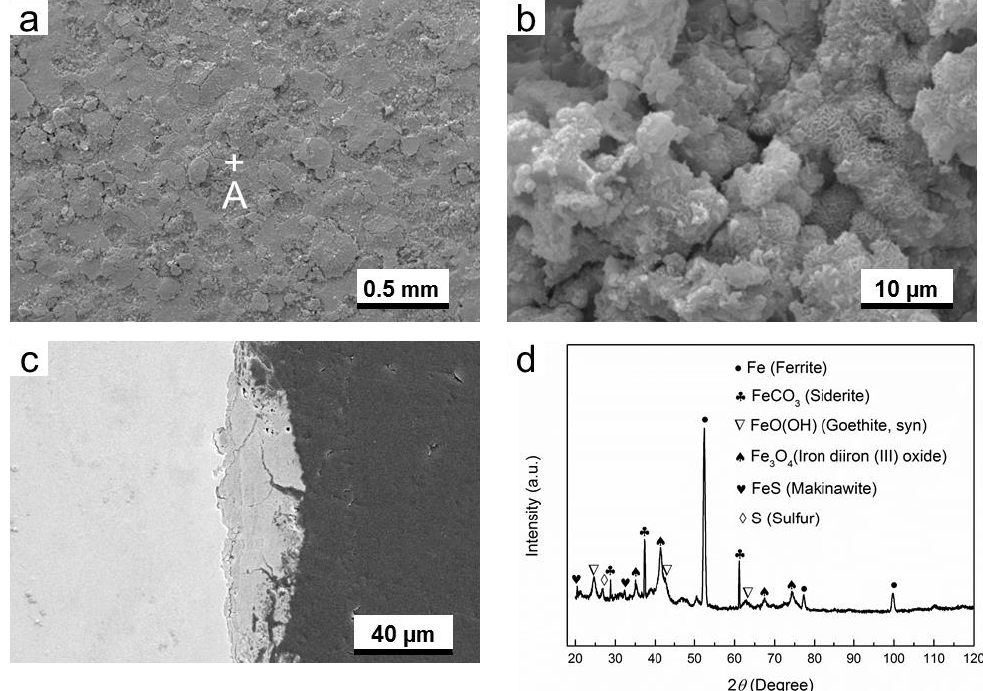
Figure 9. The characterization of corrosion products on G20 steel in liquid phase in O 2 -H 2 S-coexisting environment: ( a ) SEM image of the surface of corrosion products, ( b ) the higher magnification of region A marked in ( a ), ( c ) corrosion-sectional image of corrosion products layer, and ( d ) XRD pattern of the corrosion products.